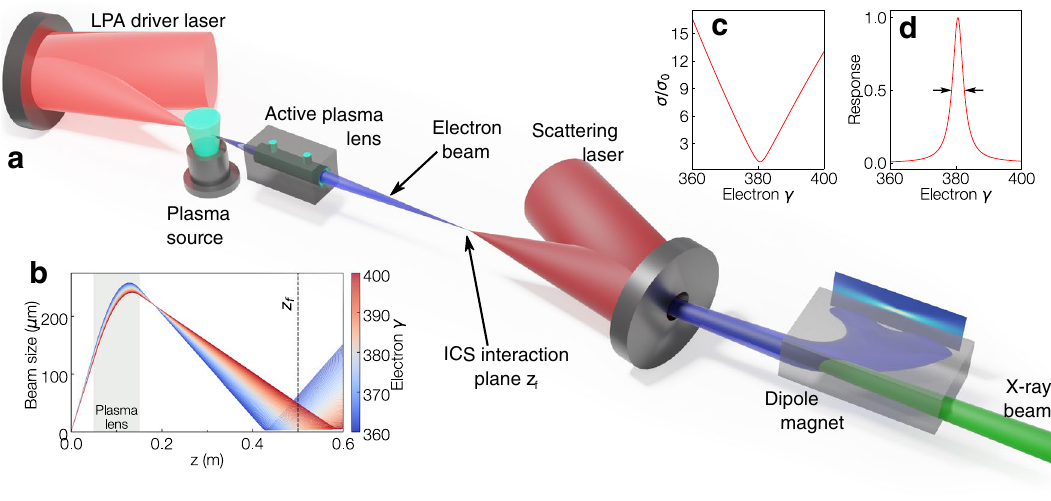
Figure 1. Schematic overview of the active plasma lens-tunable X-ray source. ( a ) A laser beam is focussed into a plasma source, generating an electron bunch. The electron bunch is captured and refocussed chromatically using an active plasma lens and interacts with a focussed scattering laser (potentially from a different, synchronised laser system) at a plane z f , generating X-rays via ICS. The electron bunch is deflected with a dipole magnet, leaving the X-ray beam. ( b ) Trajectories of electrons with different energies being focussed by an active plasma lens, highlighting the chromaticity of the focussing. ( c ) The energy-dependence of RMS electron spot size at z f . ( d ) The filtering response function Eq. (2) as a function of electron energy. The trajectories are calculated with lens current I APL = 500 A